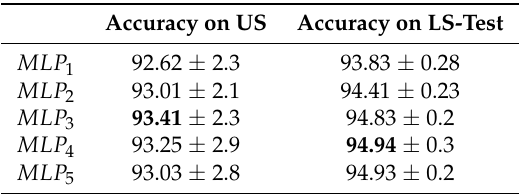
Table 2. Gait phase classification accuracy ( ± standard deviation (SD)) averaged over the 23 folds for each considered